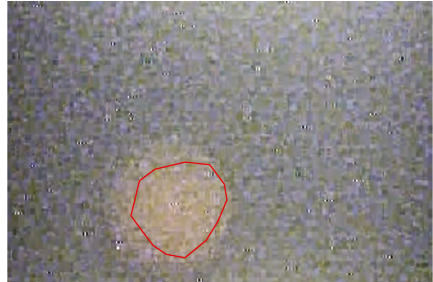
Figure 15: Segmentation of a mine at sea with pre-processing and segmentation using RGB information. C good = 0 . 53 and C false = 0.